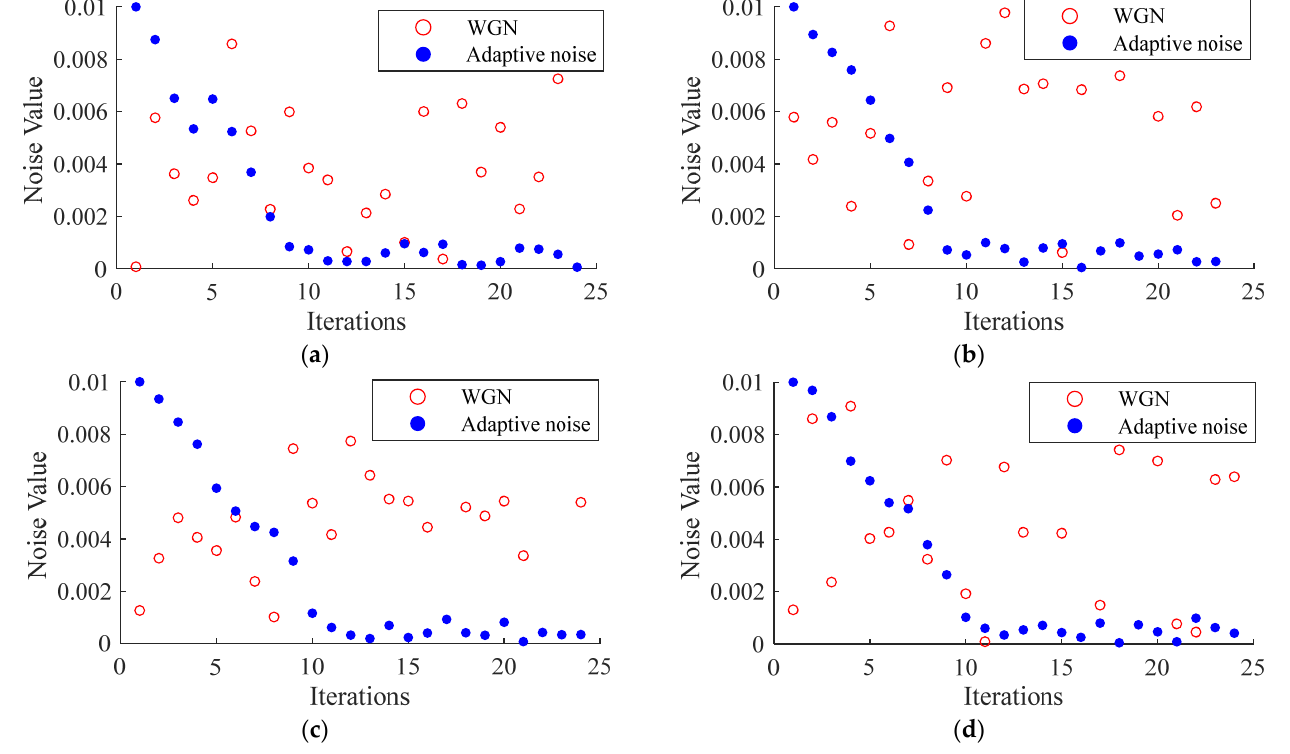
Figure 3. WGN and adaptive noise contrast chart. ( a ) Noise comparison in the first iteration; ( b ) noise comparison in the second iteration; ( c ) noise comparison in the third iteration; ( d ) noise comparison in the fourth iteration.